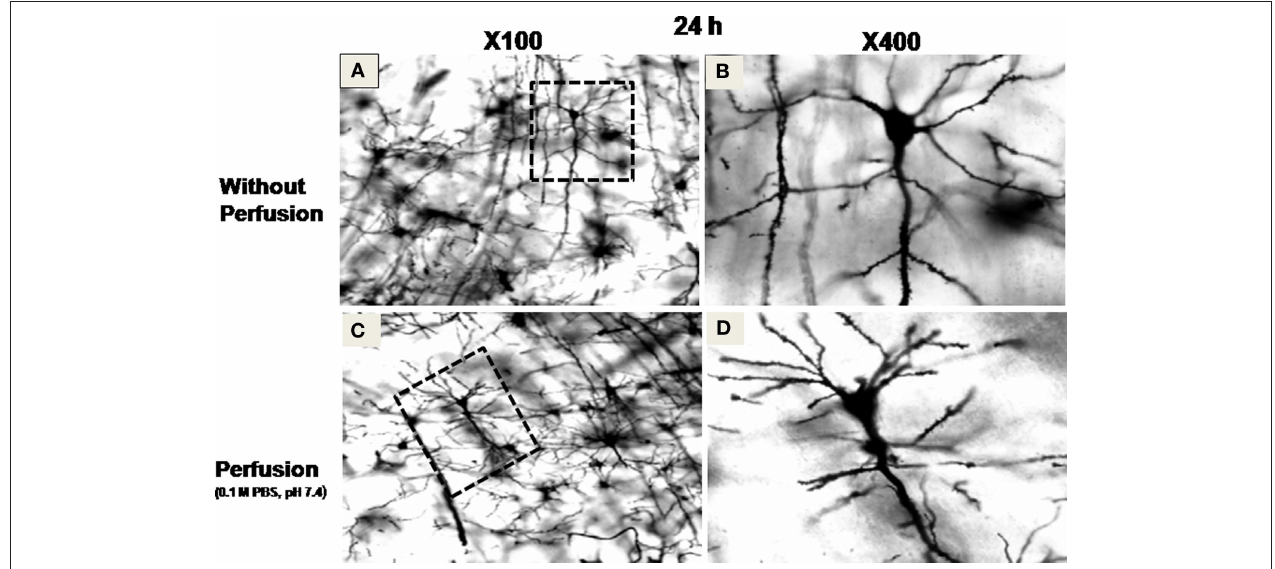
FIGure 2 | Stained neurons in sections prepared from brain blocks incubated at 37 ± 1 ° C for 24 h. Sections ( A) and ( B) were prepared without perfusion of the brain, while sections ( C ) and ( D ) were prepared after intracardial perfusion of the brain with 0.1 M phosphate buffered saline (PBS) at pH 7.4. ( A ) and ( C ) at × 100 magnification, while ( B ) and ( D ) at × 400 magnification of the area marked on ( A ) and ( C ), respectively, showing completely filled neurons.